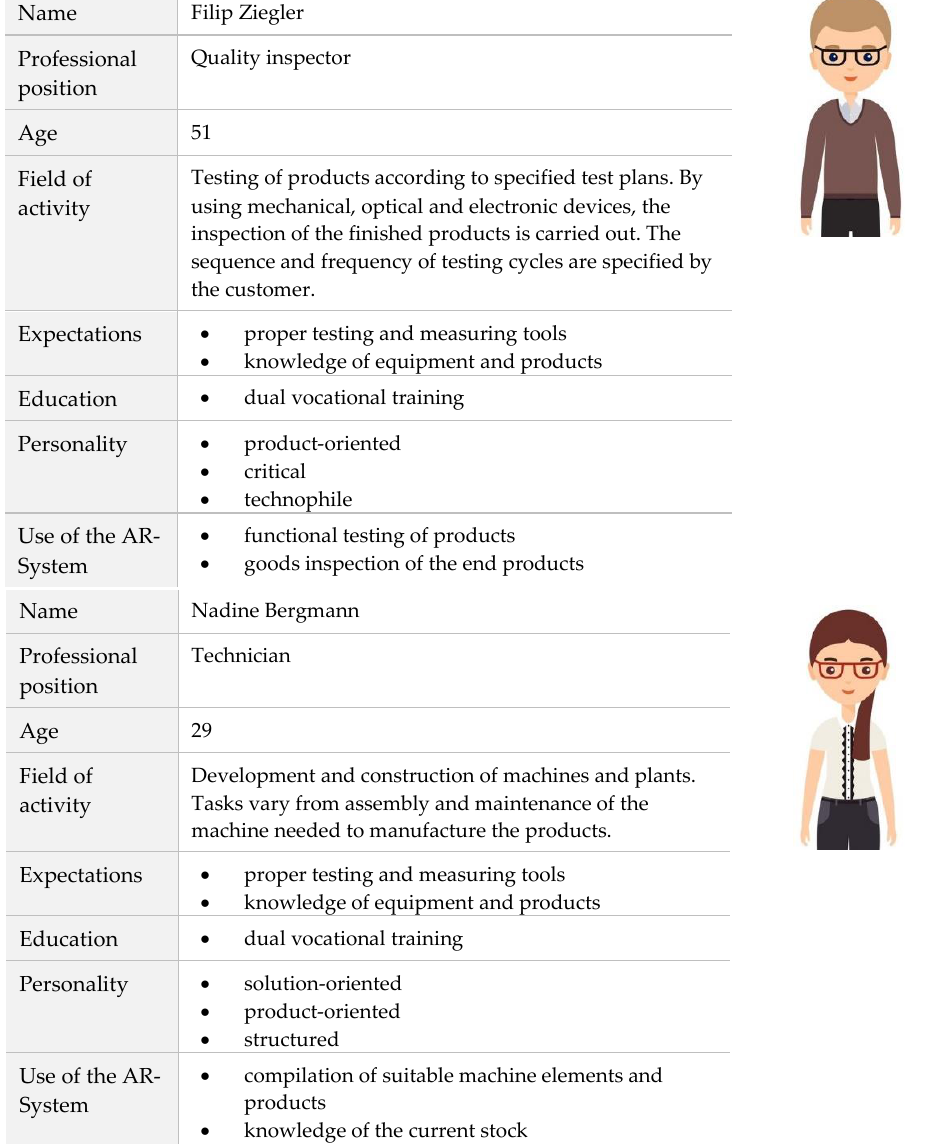
Figure 1. Persona (from top left to bottom right: planner, trainer, quality inspector, and technician).